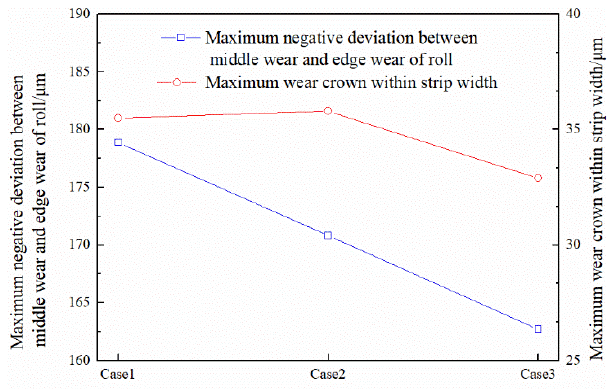
Figure 12. The indexes of wear contour under different number strips of a rolling cycle.